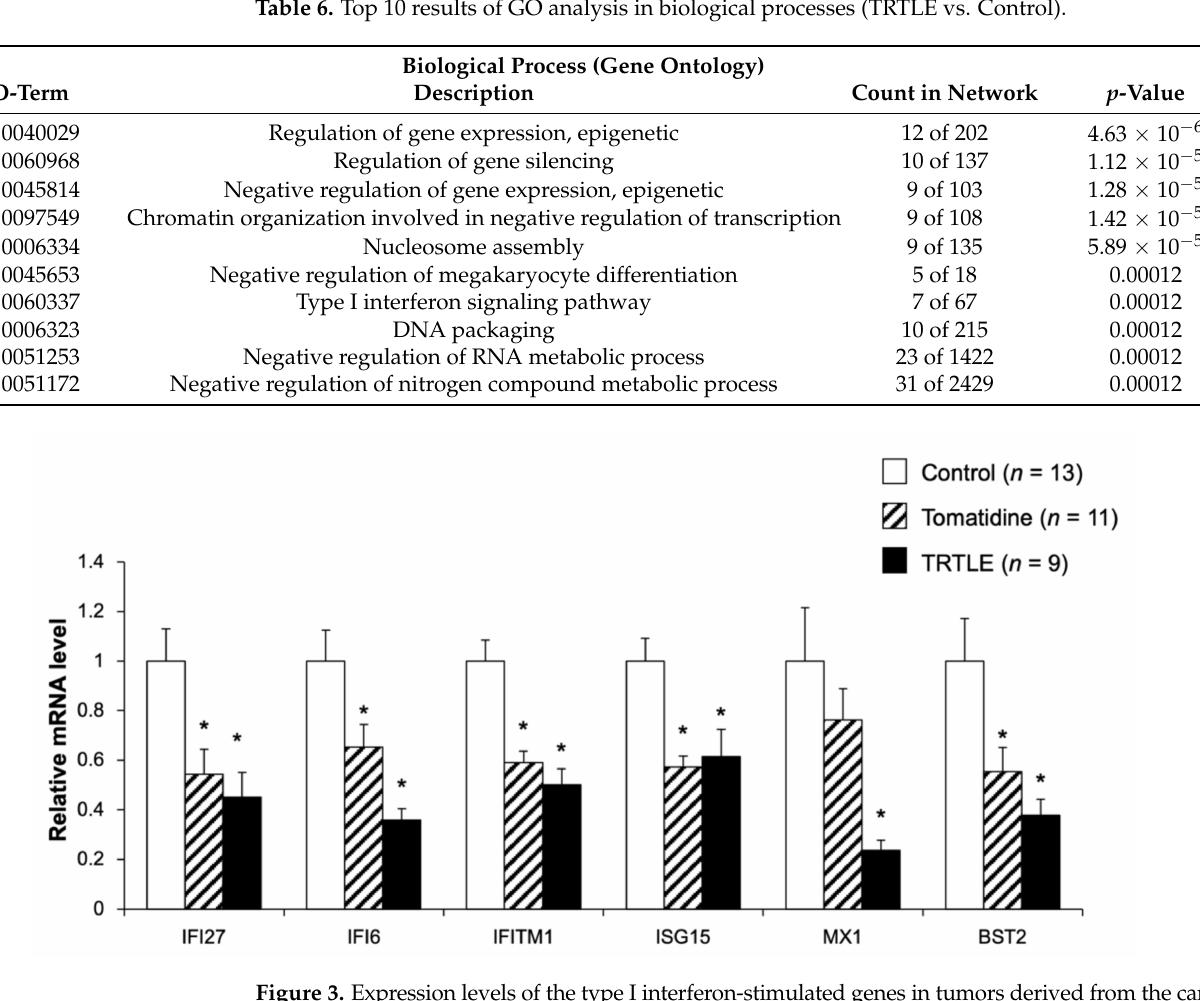
Figure 3. Expression levels of the type I interferon-stimulated genes in tumors derived from the cancer mouse model induced by the implantation of 85As2 cells. To confirm the effects of tomatidine and TRTLE, gene expression levels in tumors from the cancer mouse model fed control diet (Control) or diets containing tomatidine (Tomatidine) or TRTLE for 3 weeks were measured using quantitative reverse transcription-polymerase chain reaction (qRT-PCR). n = 9–13, means ± SE. * p < 0.05 vs.